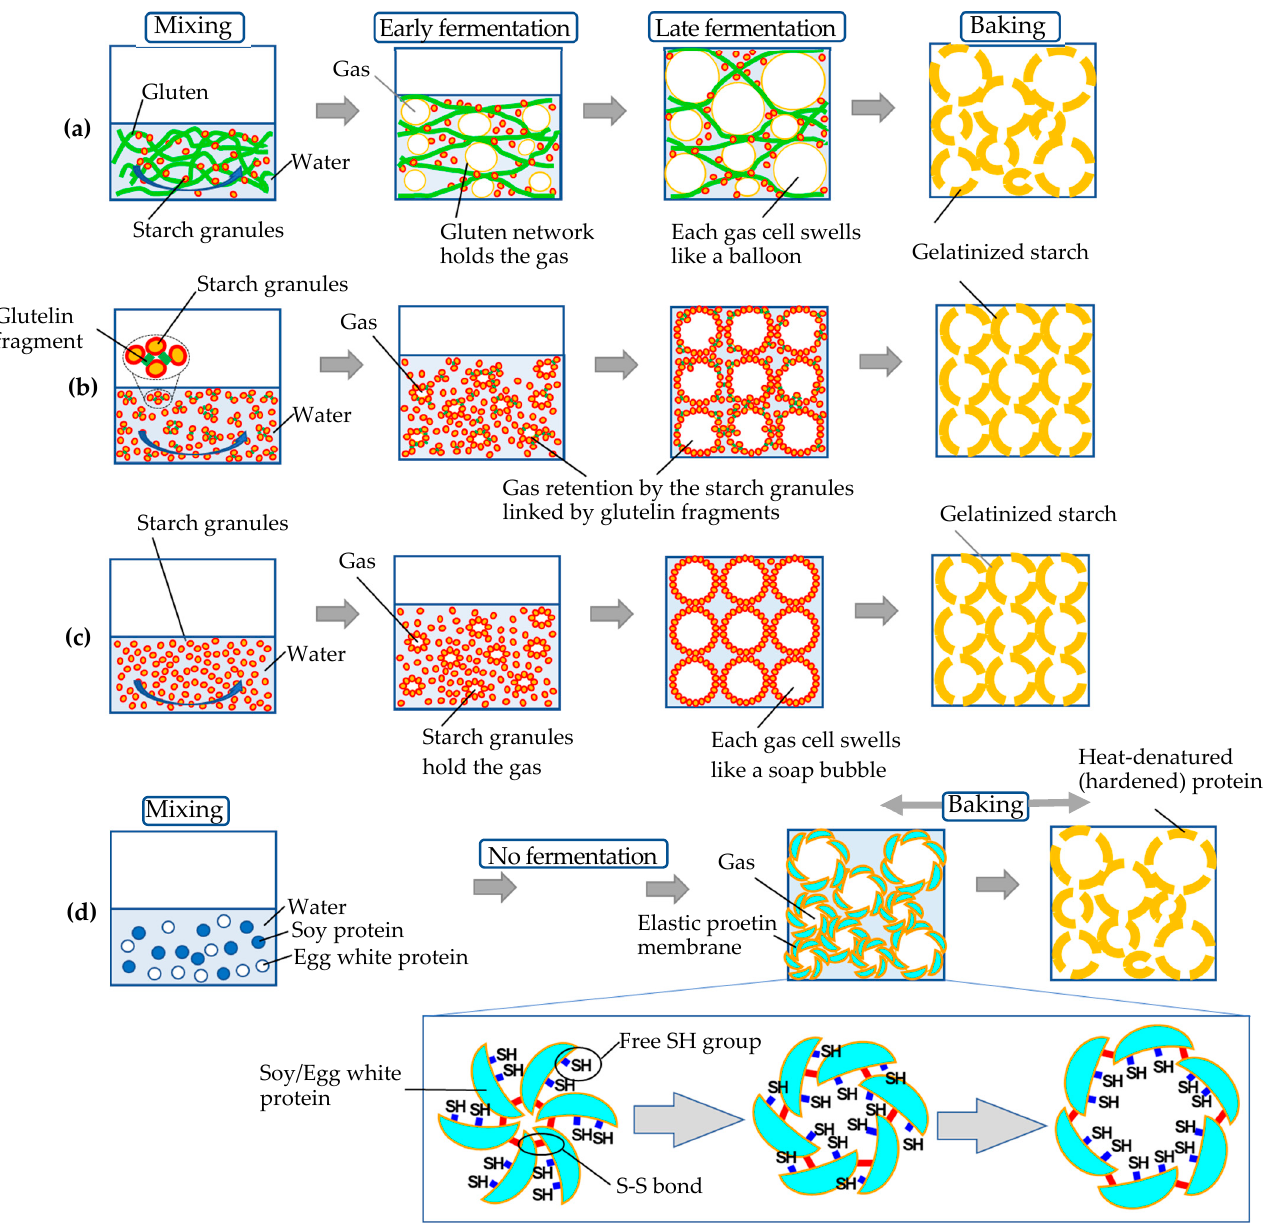
Figure 1. Comparison of the respective breadmaking processes: ( a ) conventional wheat bread; ( b ) protease-treated gluten-free rice bread [21]; ( c ) additive-free, gluten-free rice bread [22]; and ( d ) high-protein, low-carbohydrate bread made of soy protein and raw egg white [23]. ( a , c ) Adapted from references